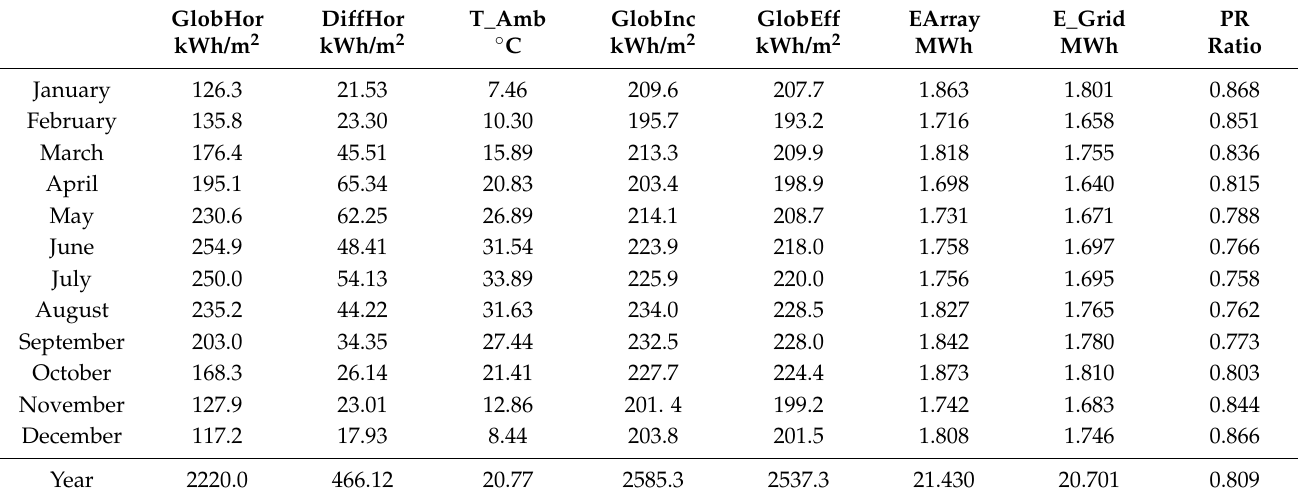
Table 5. Balance and main results for the Meybod area in 2022.